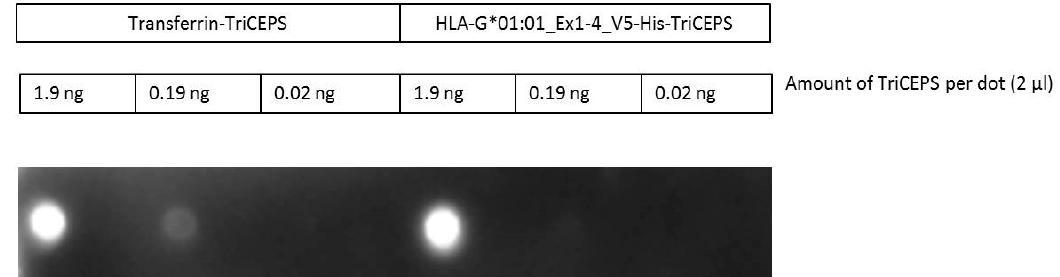
Figure A4. Coupling with sHLA-G and TRF1 was successful. The positive control transferrin and the ligand of interest sHLA-G*01:04 were coupled to the TriCEPS molecule. The success of the coupling reaction was observed by performing of a dot blot. Only coupled TriCEPS is able to diffuse into the membrane. The dot blot was performed in 3 different dilutions: 1.9 ng TriCEPS /2 µL, 0.19 ng TriCEPS /2 µL, and 0.02 ng TriCEPS /2 µL.